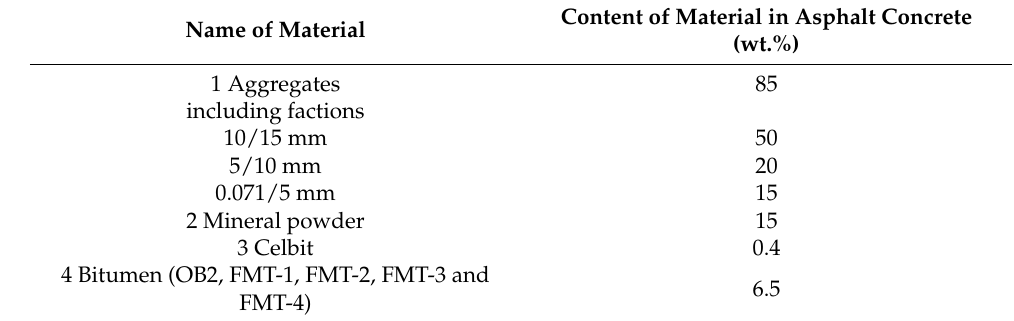
Table 5. Composition of SMAM-15.